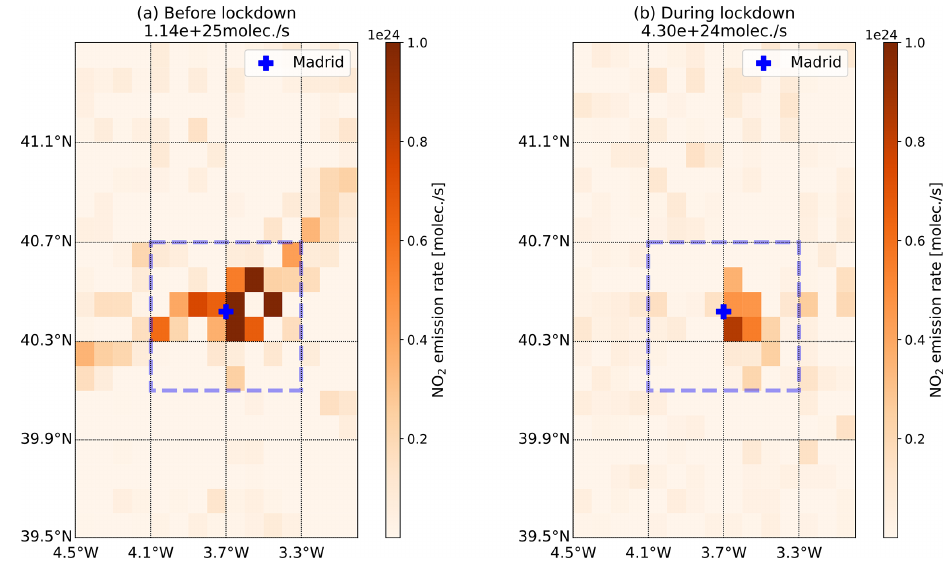
Figure 6. The same as Fig. 5 but for the Madrid area. The number in each panel heading presents the total emission rate in the dashed rectangle (70 × 70km 2